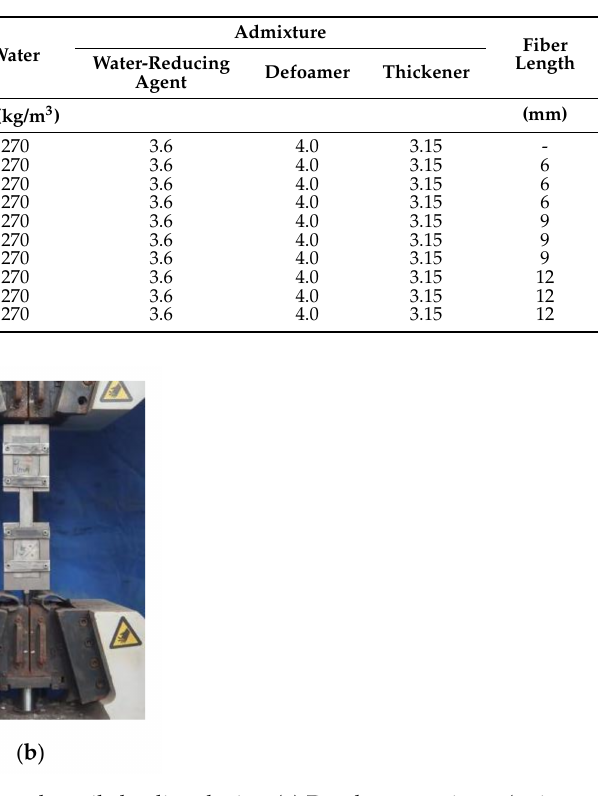
Table 2. Mix proportions of PVA fiber-reinforced coral cement-based composites.